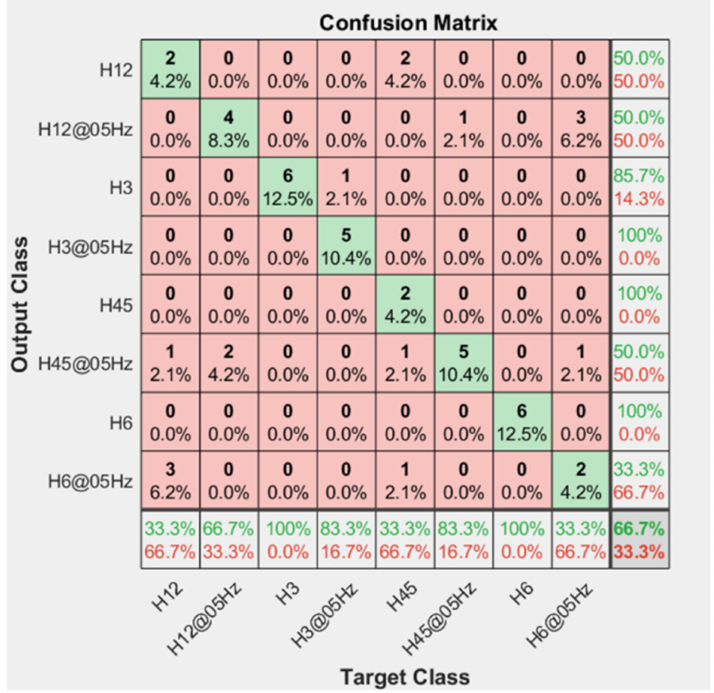
Figure 19. Confusion matrix (test set) for the eight class setup with spectrogram images.